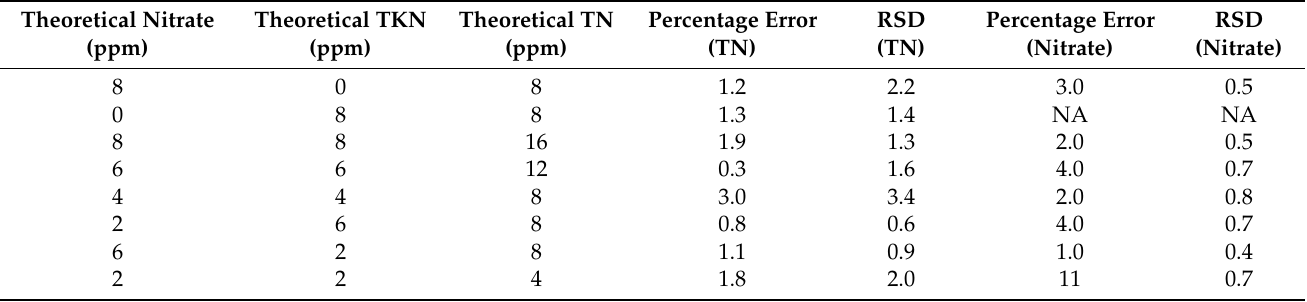
Table 5. Percent rate and RSD of TN and nitrate in a mixed glycine–nitrate standard using the s-TKN TM